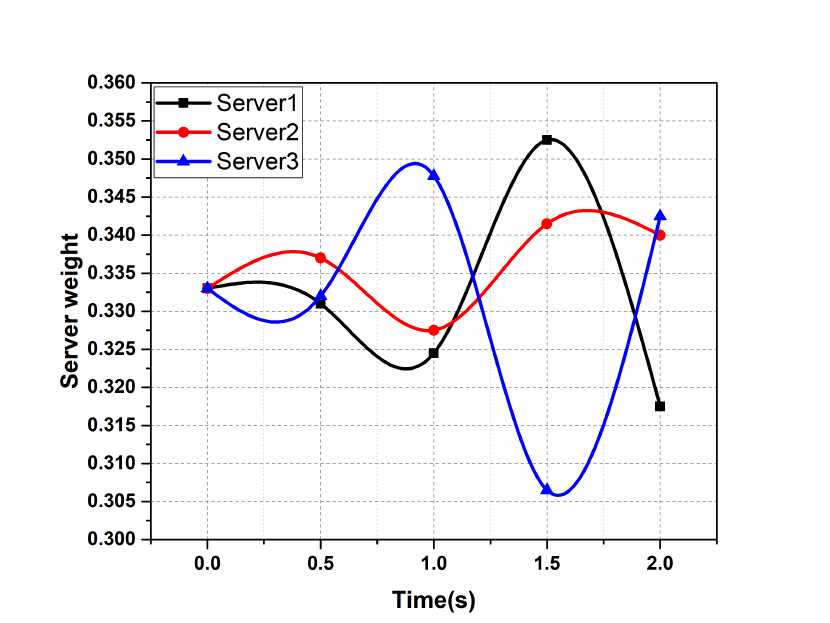
Figure 5. The weight fluctuations of different servers over time.